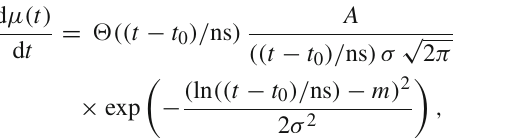
input signal (bottom panel) is designed to have a “double bump”, and it consists of two consecutive log-normals sepa- rated by a time interval (cid:5) t (equal to the difference between the two location parameters t 0 , 2 − t 0 , 1 ) of our choice. Both ( E / eV ) = 18 . 1and θ ≈ 30 ◦ (sin 2 θ = 0 . showeroflog 10